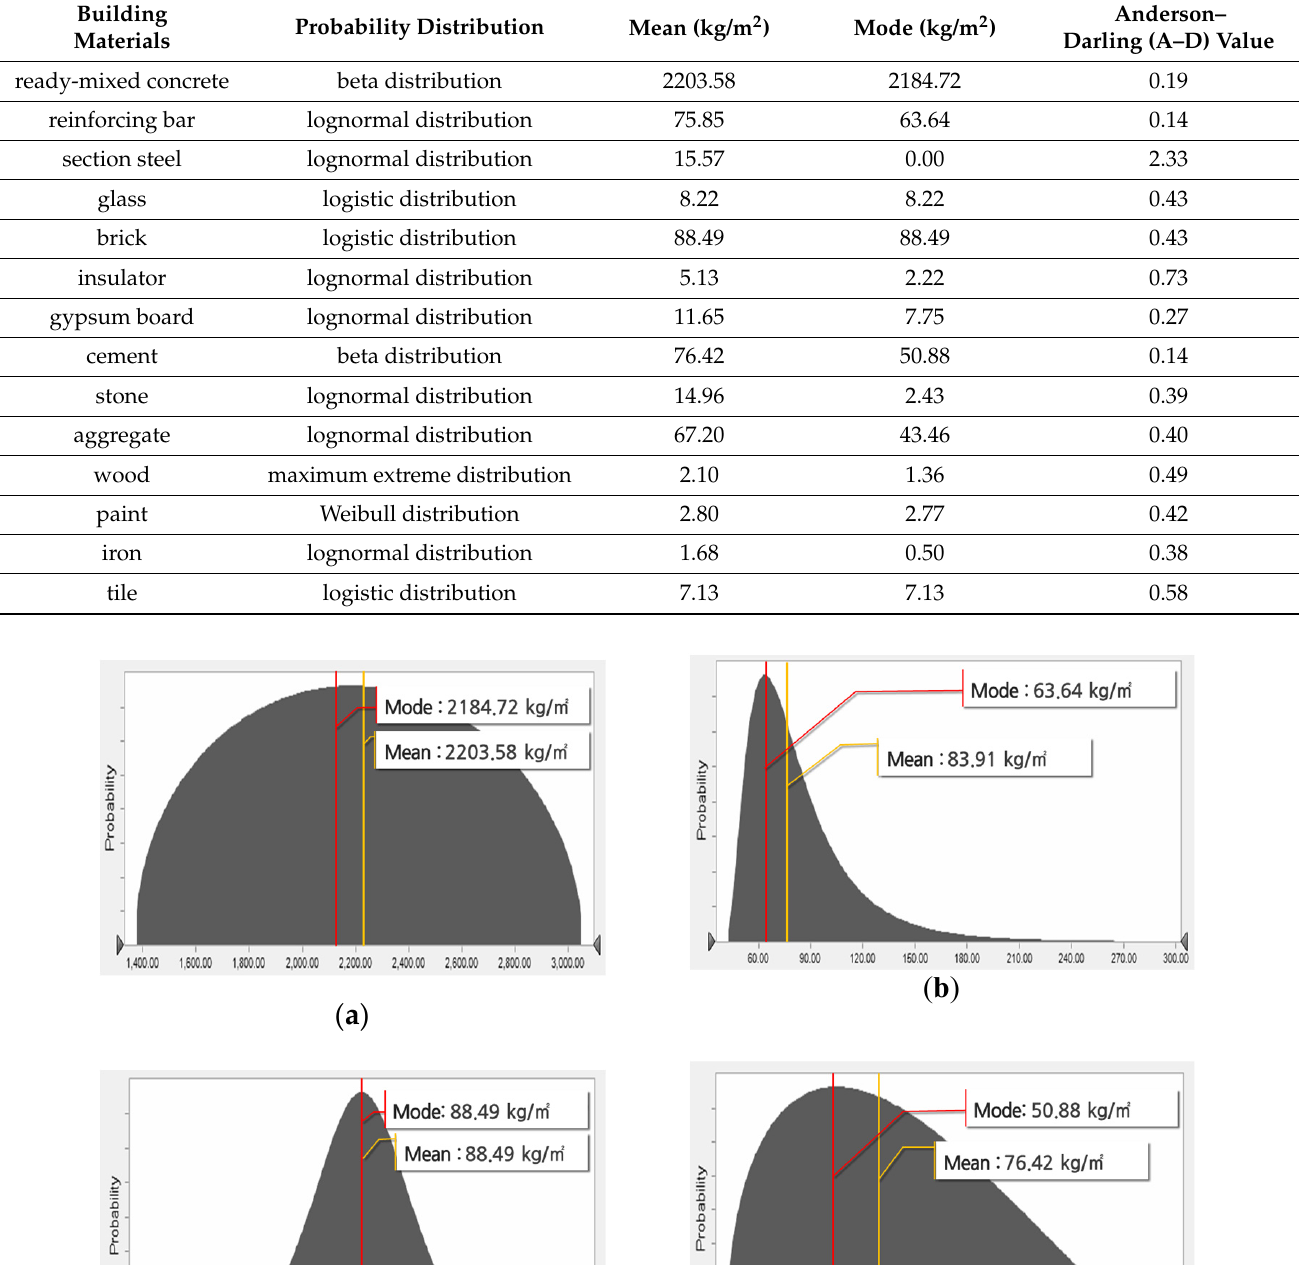
Table 3. Probability distributions of various building materials.